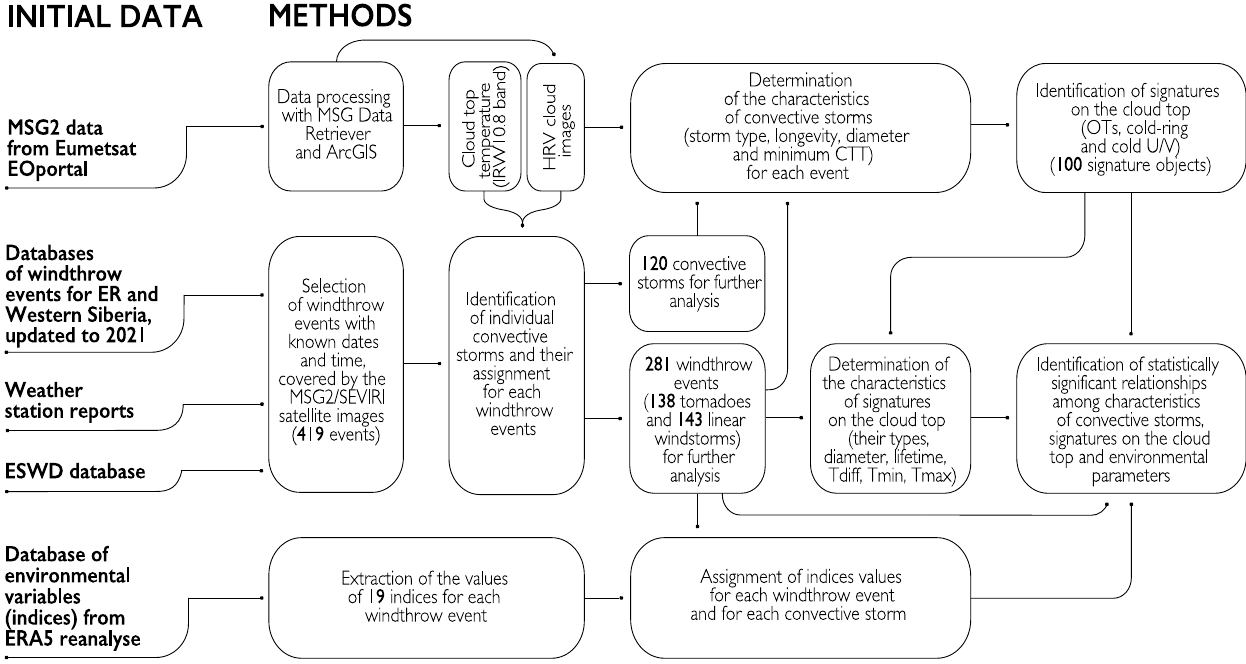
Figure 4. The workflow used in this study for mutual analysis of windthrow events, satellite-derived characteristics of convective storms, and environmental variables from the ERA5.